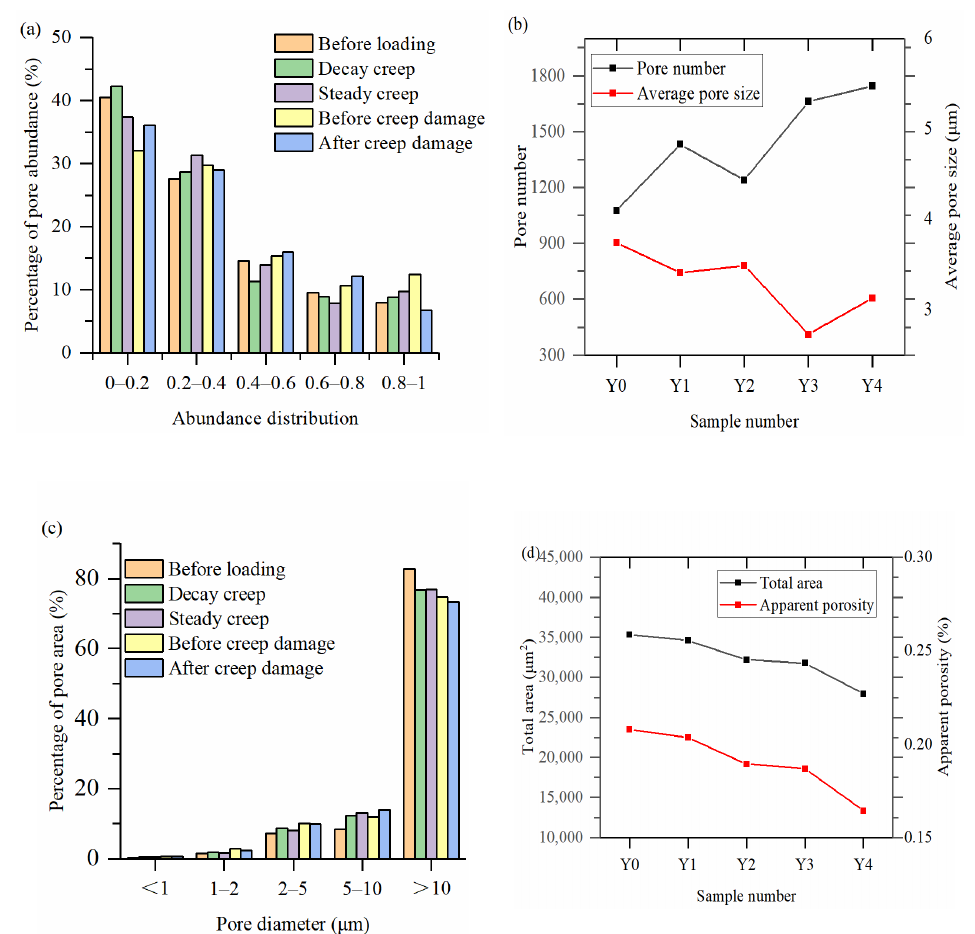
Figure 8. Quantitative analysis of pore space of intact loess. ( a ) Histogram of pore content histogram; ( b ) number of pores and average pore size; ( c ) histogram of pore area distribution; ( d ) total pore area and apparent porosity.